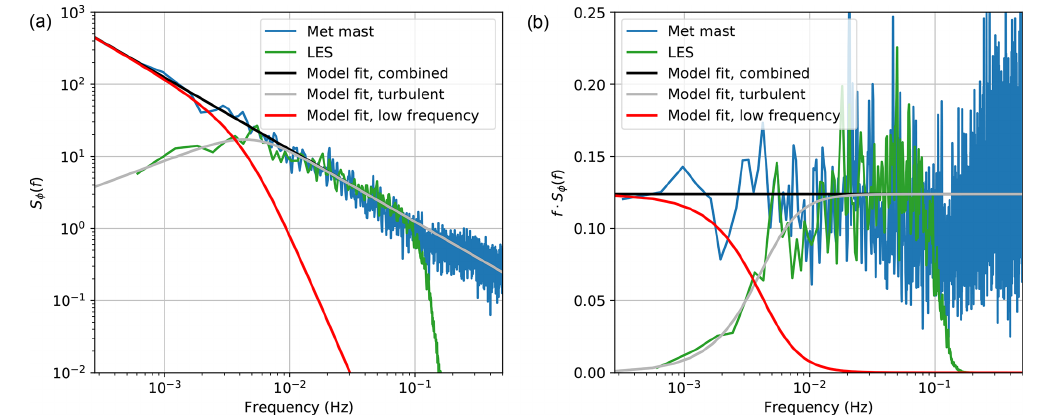
Figure 4. Normalized power spectra of the wind direction determined from met mast wind vane measurements, the turbulent wind direction component derived from LES, and the resulting low-frequency wind direction component (a) ; the same power spectra multiplied by frequency (b)